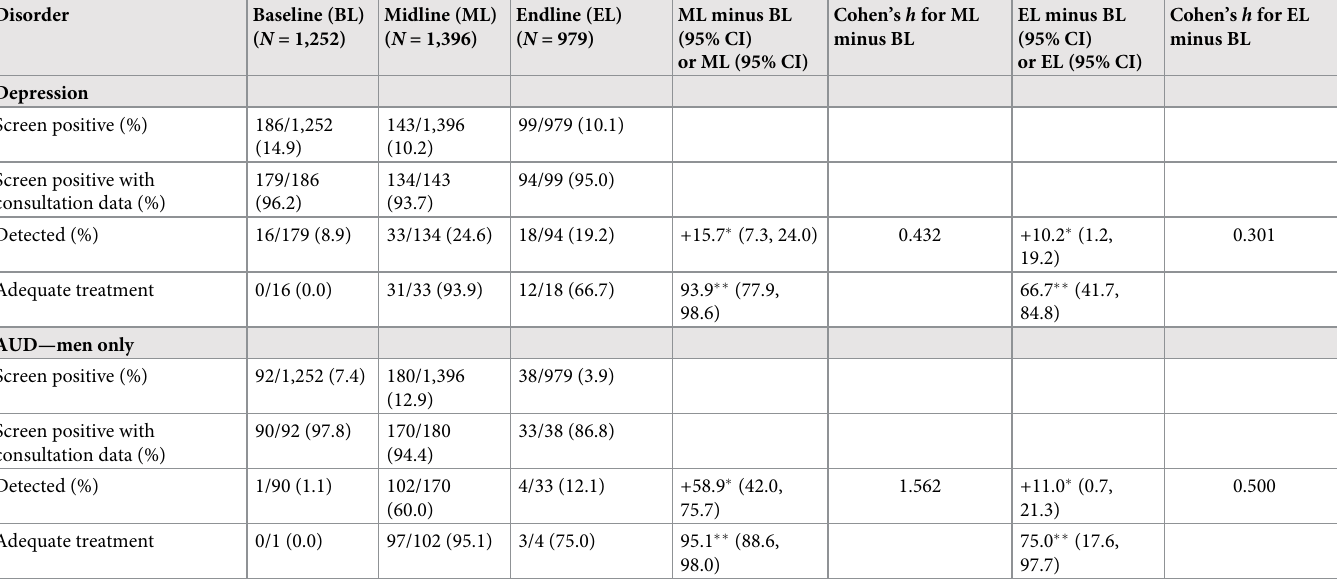
Table 6. Clinical detection of depression and of AUD among adult government health clinic attendees, Chitwan, Nepal, 2013–2017.